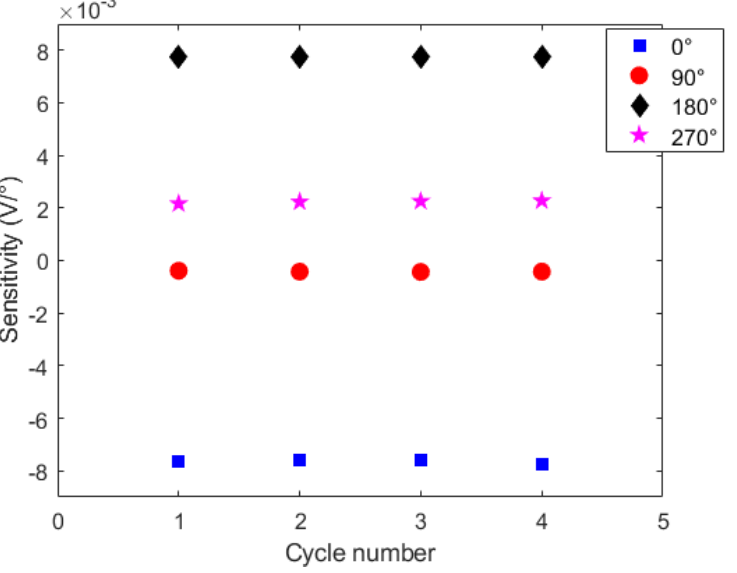
Figure 7. Sensor sensitivities for all cycles at each tested lateral section positioning.